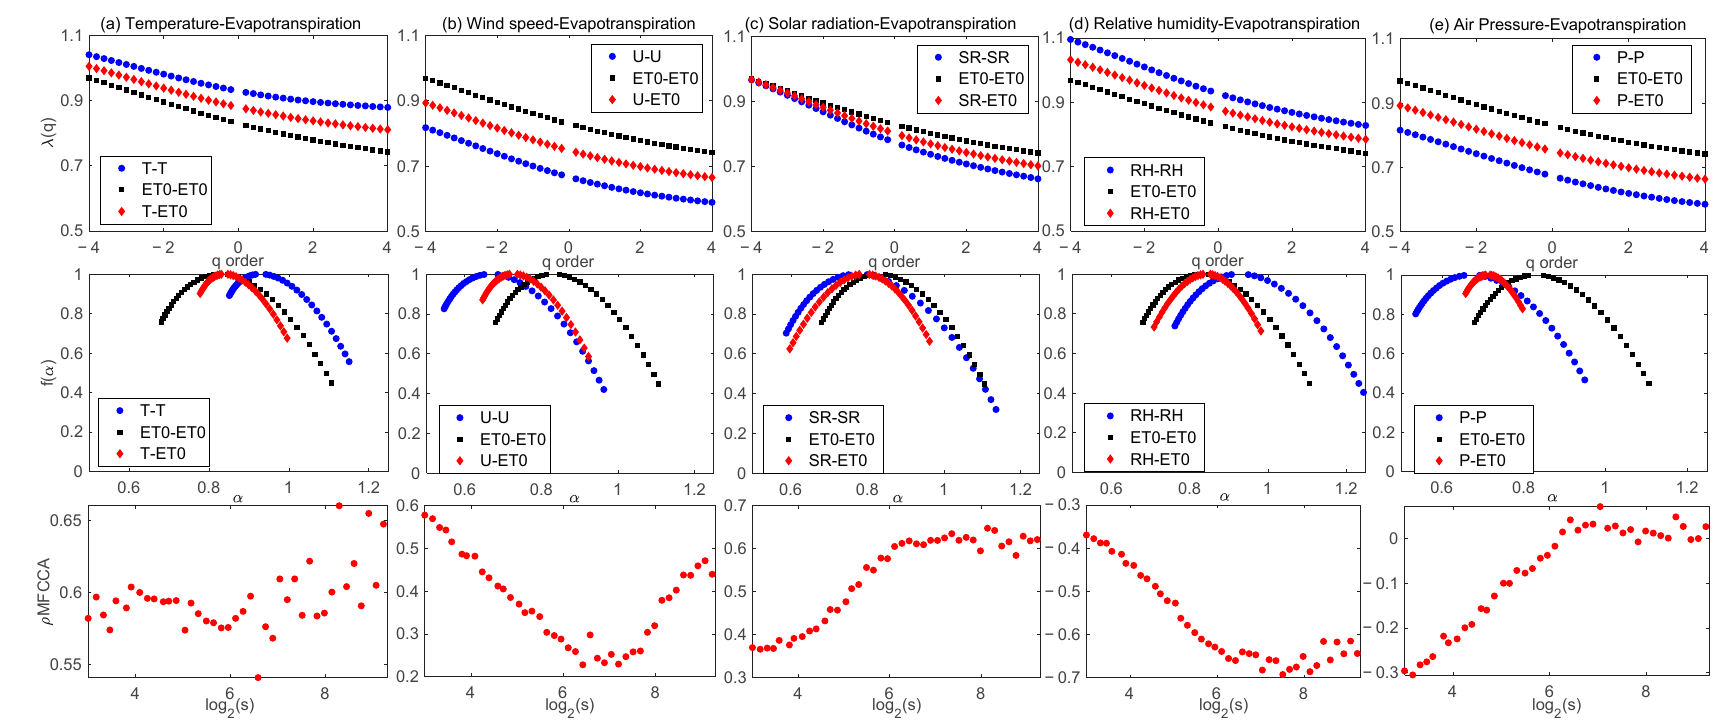
Figure 7. GHE plots (upper panels), multifractal spectra (middle panels) and cross-correlation plots (lower panels) obtained by MFCCA of different links at Dagget